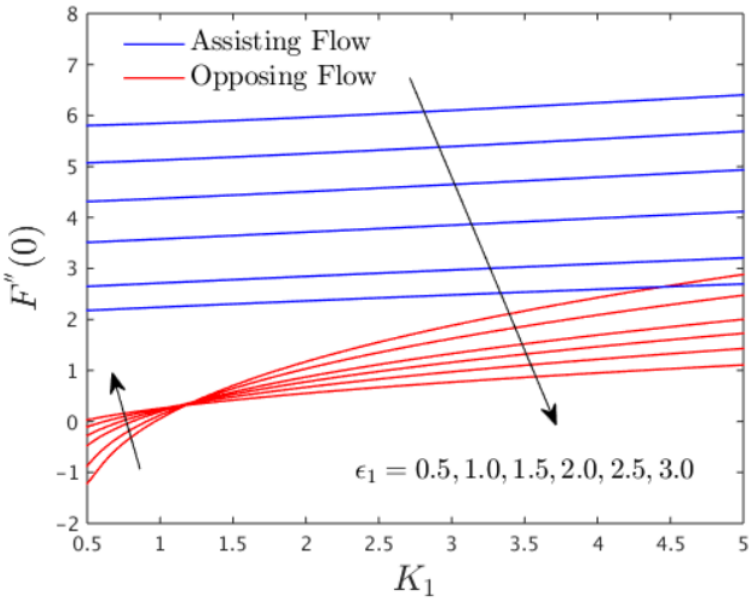
Figure 12. Variations of the shear stress for several values of ε 1 .